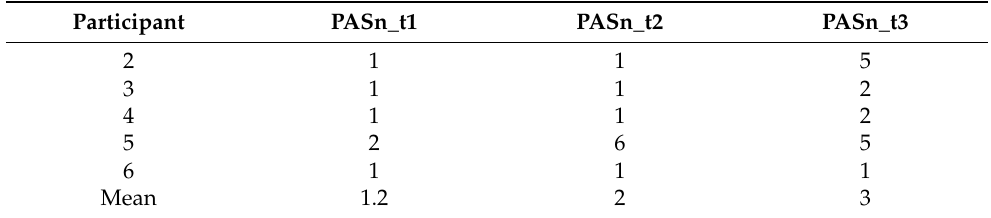
Table 26. PAS (worst), nectar 10 mL (points) individual and mean measurements at three assessment time points.